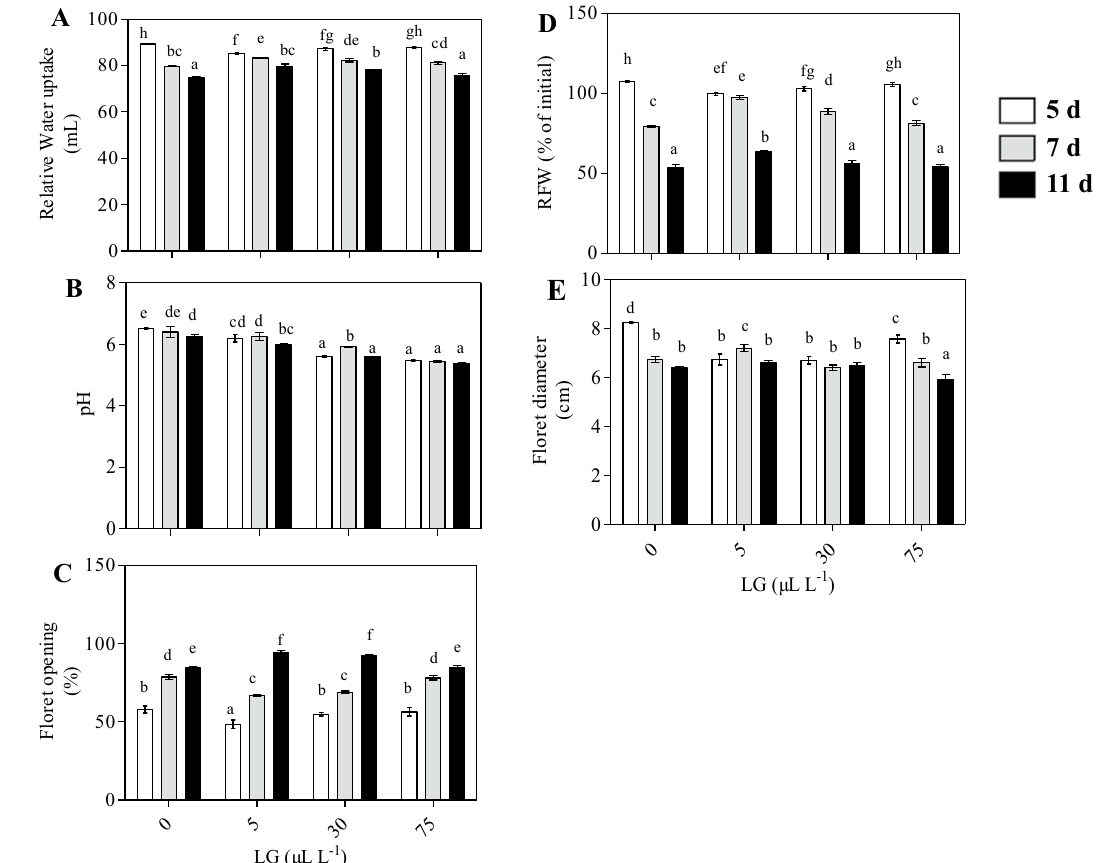
Figure 1. Morpho-physiological parameters such as relative water uptake ( A ), pH ( B ), floret opening ( C ), floret diameter ( D ), relative fresh weight ( E ), in untreated control and LG essential oil treated Gladiolus grandiflorus spikes at different vase days (d) of evaluation. The gladiolus spikes were treated with different LG essential oil concentration (0, 5, 30 and 75 µL L −1 ). Each value is the mean ± SE of three replicates. Means with different letters are significantly different at 5% probability (Tukey’s test). *Floret Diameter: Average of first, third and fifth floret was